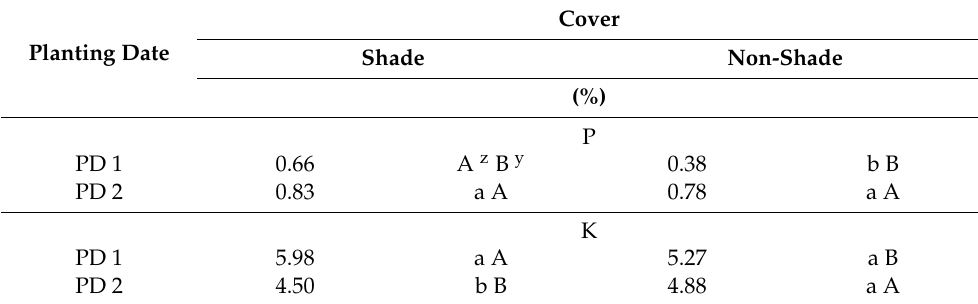
Table 5. The interaction between planting date (PD) and shading for foliar phosphorous (P) and potassium (K) concentrations on a dry weight basis in high tunnel-grown basil ‘Genovese’. Cover Planting Date Shade Non-Shade